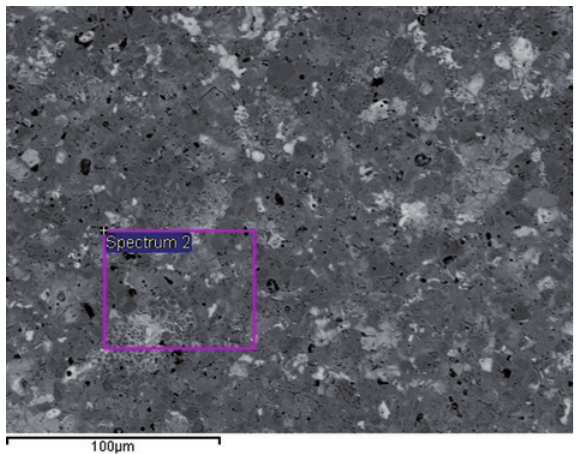
Fig. 7: SEM-BSE image of the TiCMo substrate before the experiment